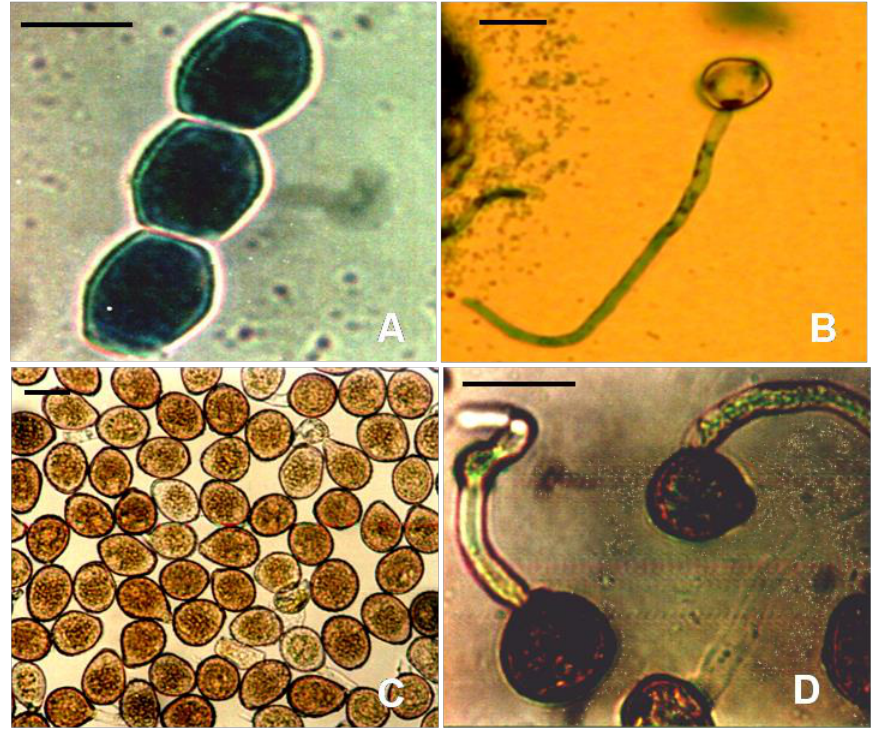
Figure 4. Morphology of various spore stages and germinating spore of U. viciae-fabae on pea. ( A ) Aeciospores ( B ) Germinating aeciospores, Bars = 24 µm ( C ) Urediospores ( D ) Germinating urediospores, Bars = 30 µm.